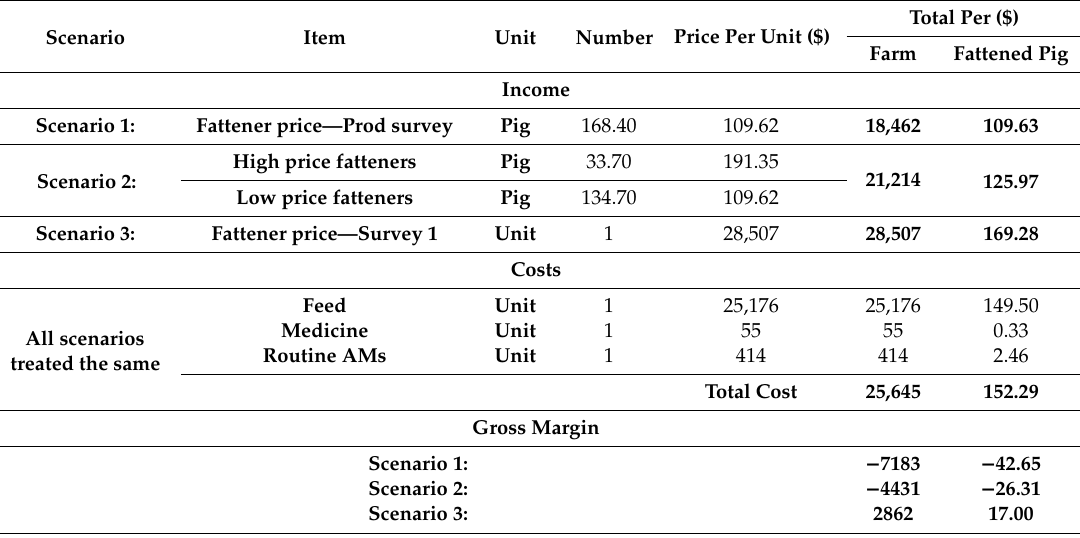
Table 4. Pig production and farm income data (minimum and maximum in brackets) ($) * Annual Gross Margin for pig enterprise in Dong